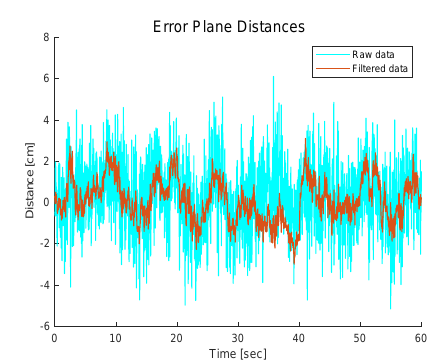
Figure 15: The plot illustrates how the estimated dis- tance to the plane was affected by the loss of vanishing point